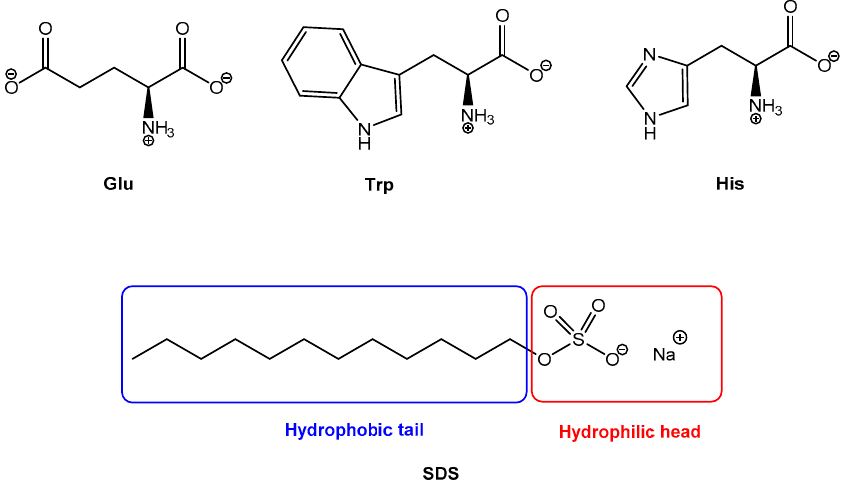
Figure 1. Structure of amino acids at pH 7, glutamic acid ( Glu ), tryptophan ( Trp ), and histidine ( His ) and sodium dodecyl sulfate (SDS).